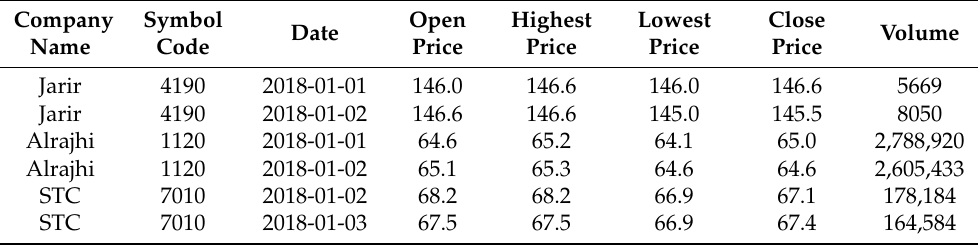
Table 1. Sample of daily trading Saudi Exchange data releases by Tadawul’s authority. Stock prices are reported in Saudi riyals